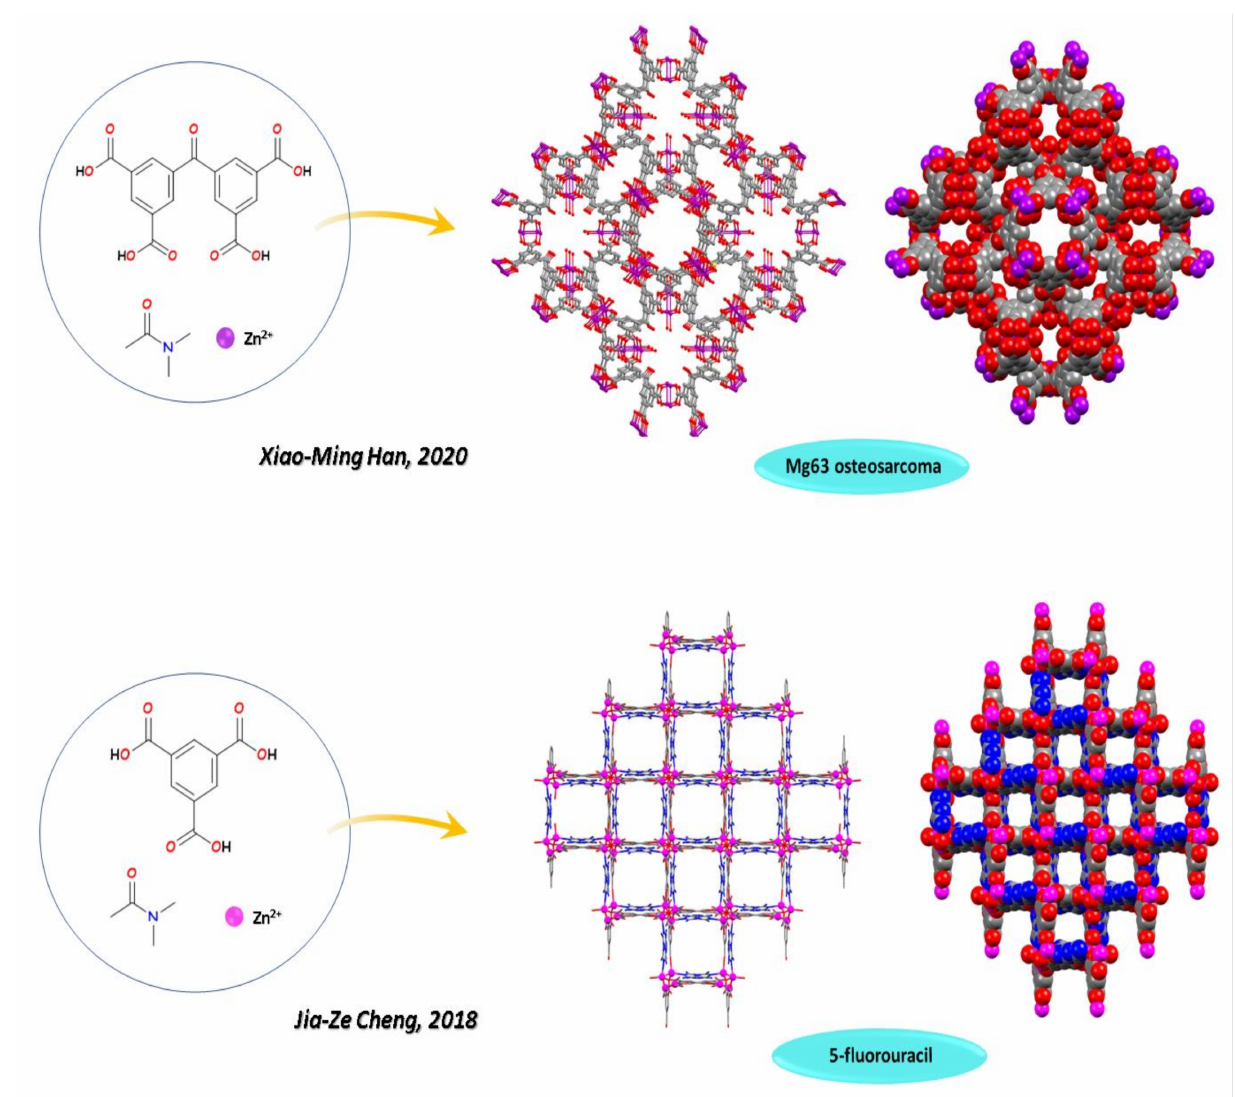
Figure 8. Some representative structures of Zn-CPs for fluorescence bioimaging. Figures readapted by using Mercury software